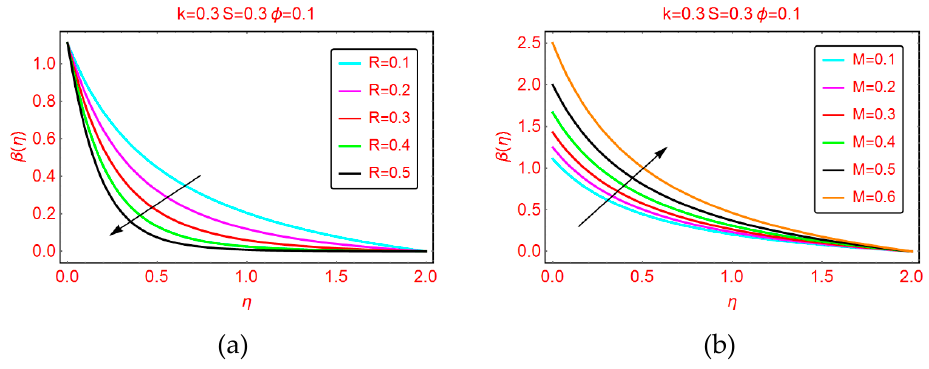
Figure 3. The temperature distribution for varying ( a ) R and ( b ) M .